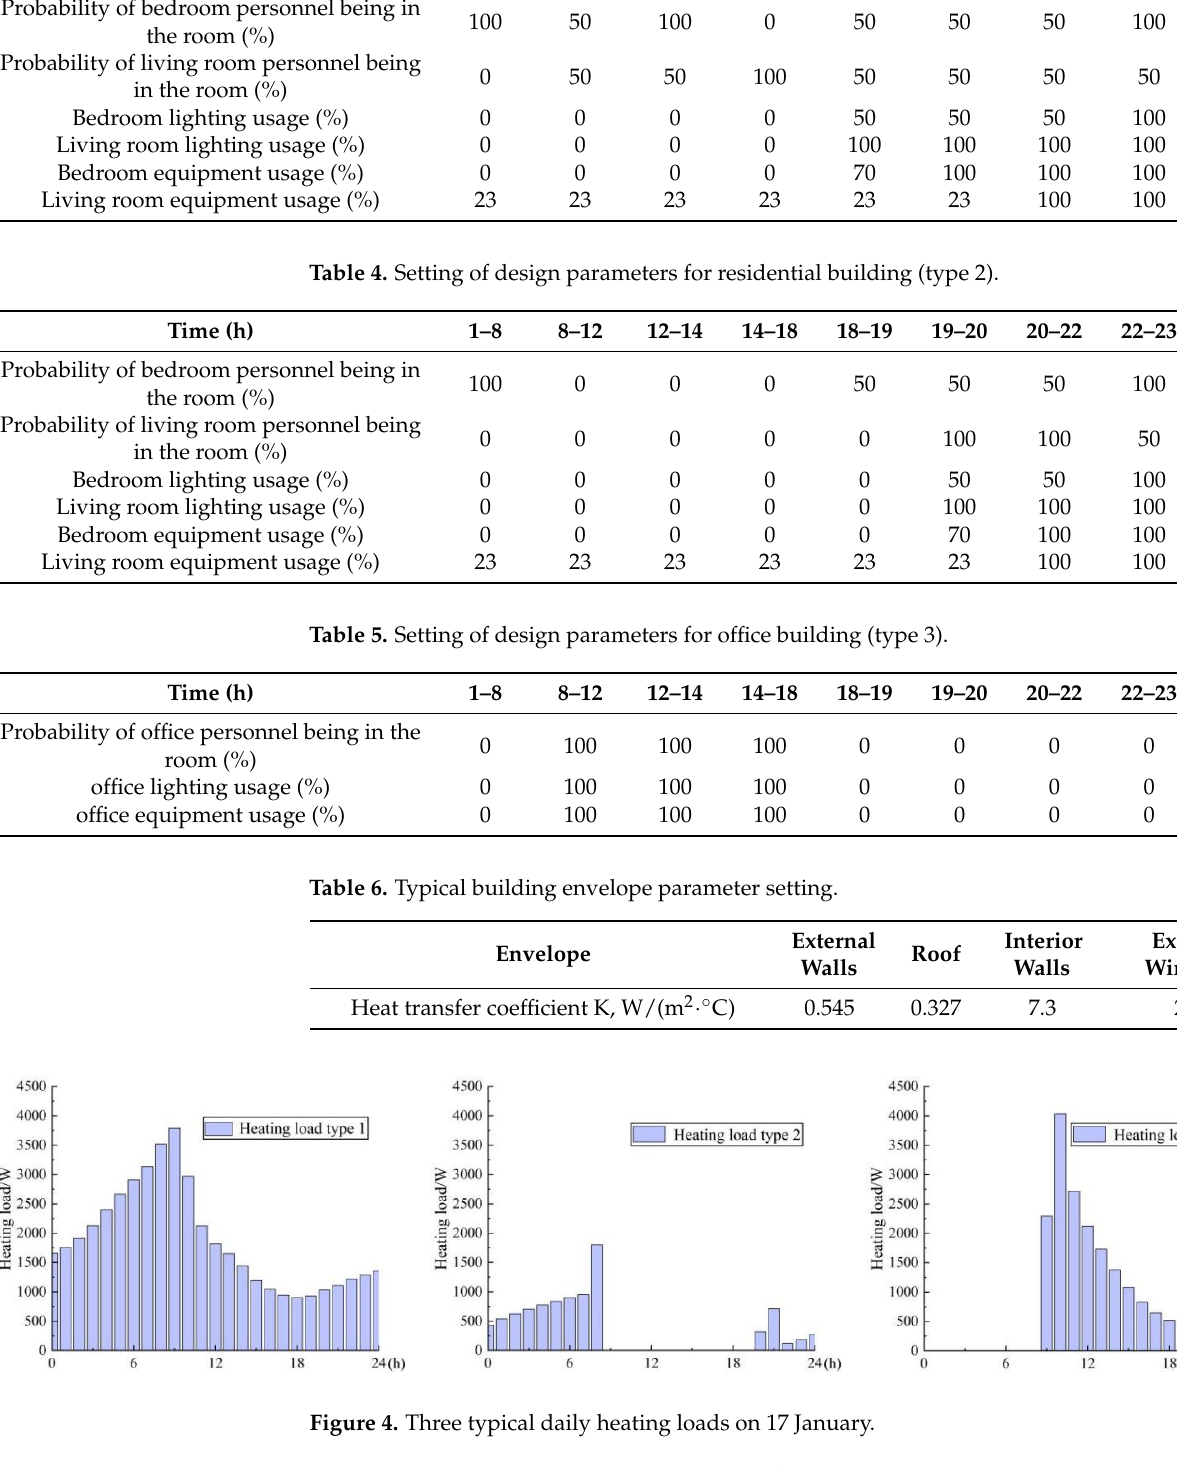
Table 3. Setting of design parameters for residential building (type 1).